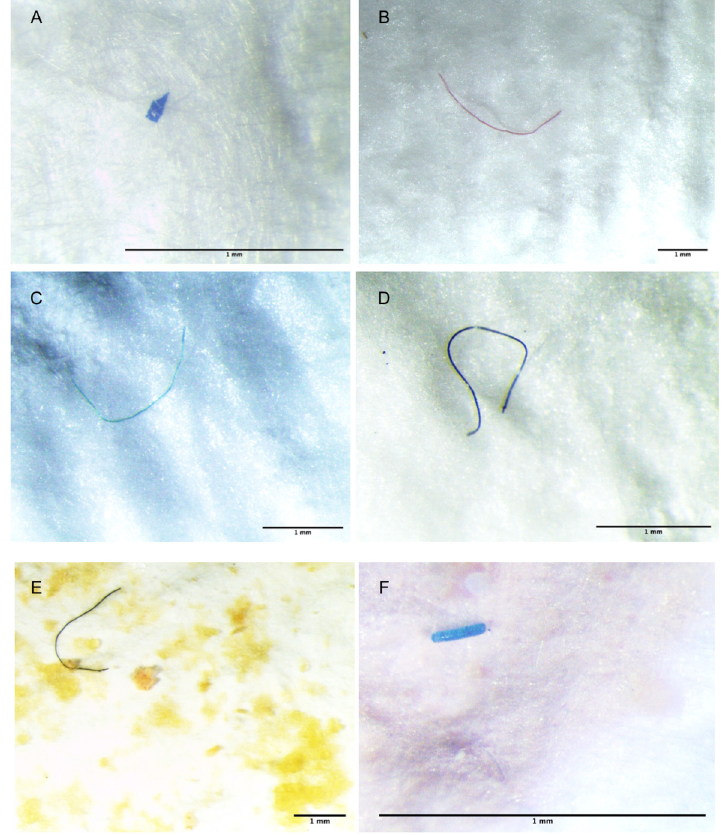
Figure 1. Representative images of AD isolated from P. longirostris ( A , B ), A. antennatus ( C , D ), and A. foliacea ( E , F ).